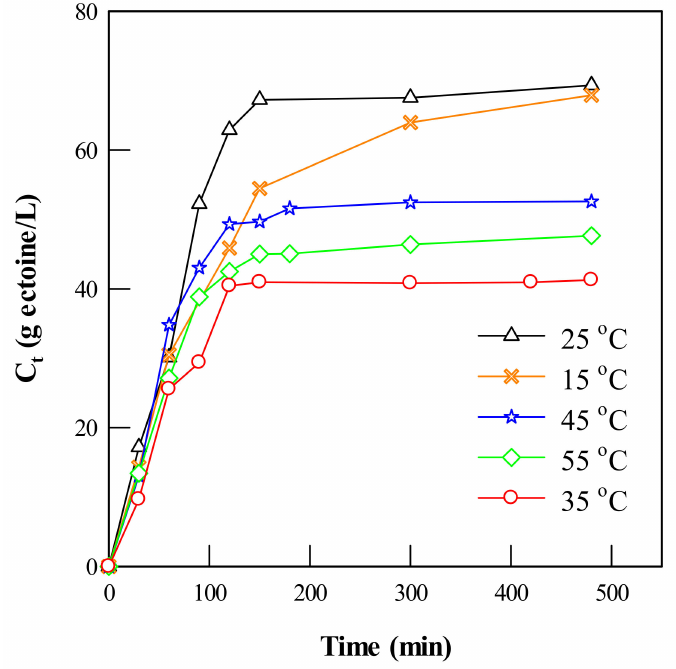
Figure 11. Effect of time on ectoine desorption from Dowex ® HCR-S with different temperatures (saturated resin/NaOH solution = 0.1 g/mL, NaOH concentration: 0.5 mol/L).